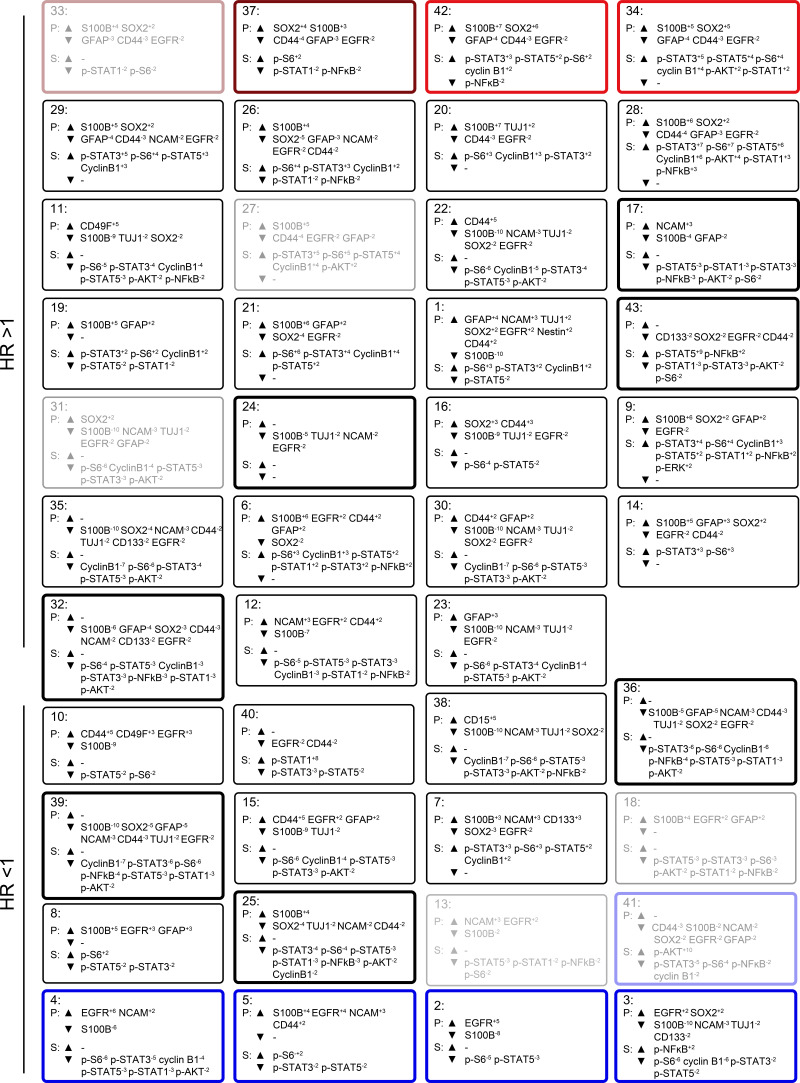
Quantitative MEM labels of the enriched identity proteins and signaling features of all glioblastoma cell subsets identified by RAPID.Enrichment of identity proteins (P) and phosphorylated signaling effectors (S) of glioblastoma cell subsets identified by RAPID was quantified using MEM. GNP and GPP cells are labeled in red and blue, respectively. Populations detected in every patient sample (abundances ranging from 0.02% to 28.05%) are outlined in bold. Populations deemed unstable (either by F-measure <0.5 or representing phenotypes displayed in less than 50% of cell subsampling runs) are faded.